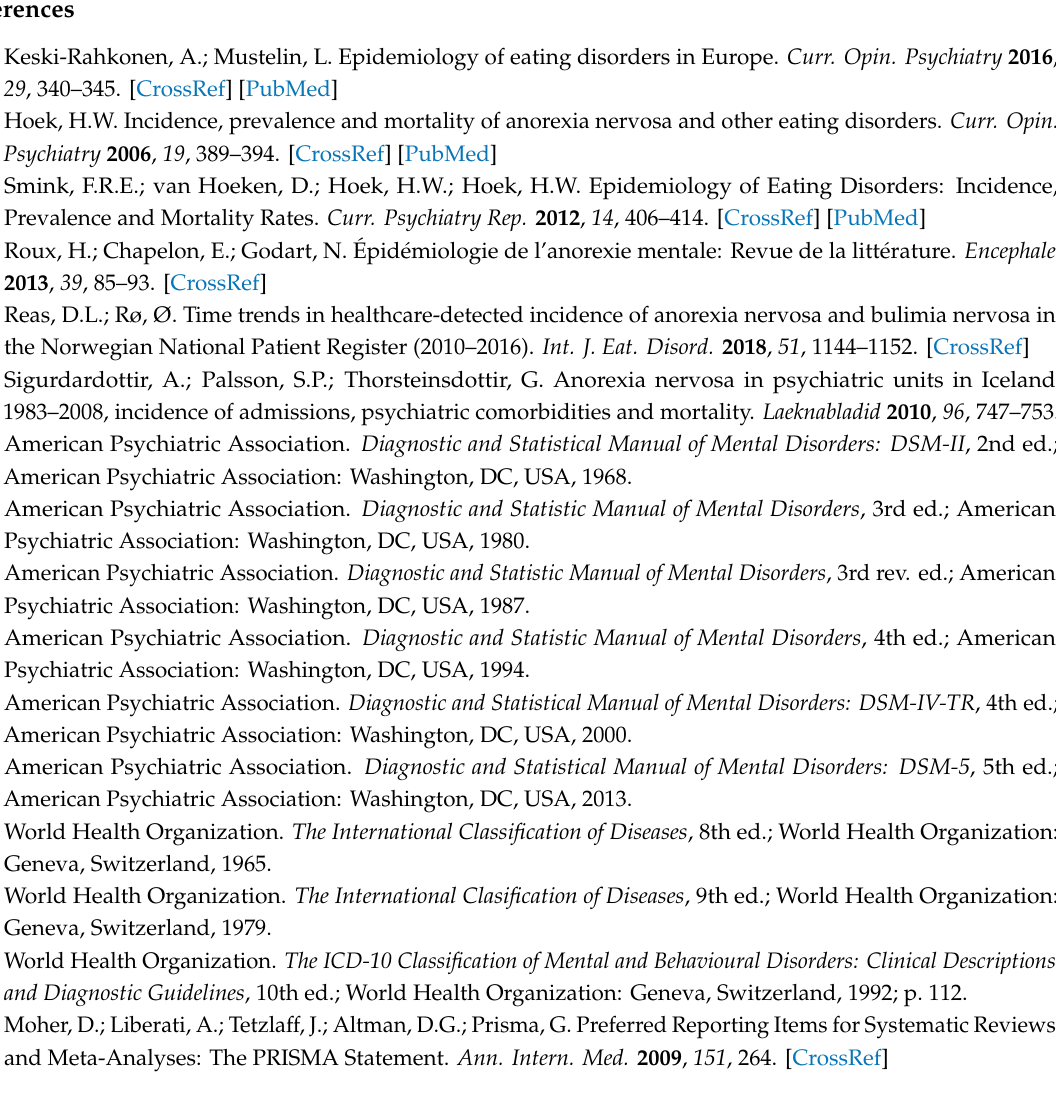
Table S1: Database literature searches from 1980 until December 2019, Table S2: Quality of the papers included in the systematicreviewbyTheNewcastle-Ottawascale, TableS3: Incidenceofanorexianervosaper100,000women-years services, Table S5: Incidence of anorexia nervosa per 100,000 women-years in cohort